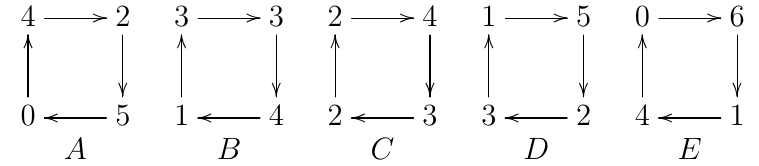
Figure 1. Five stable matchings (matching C is